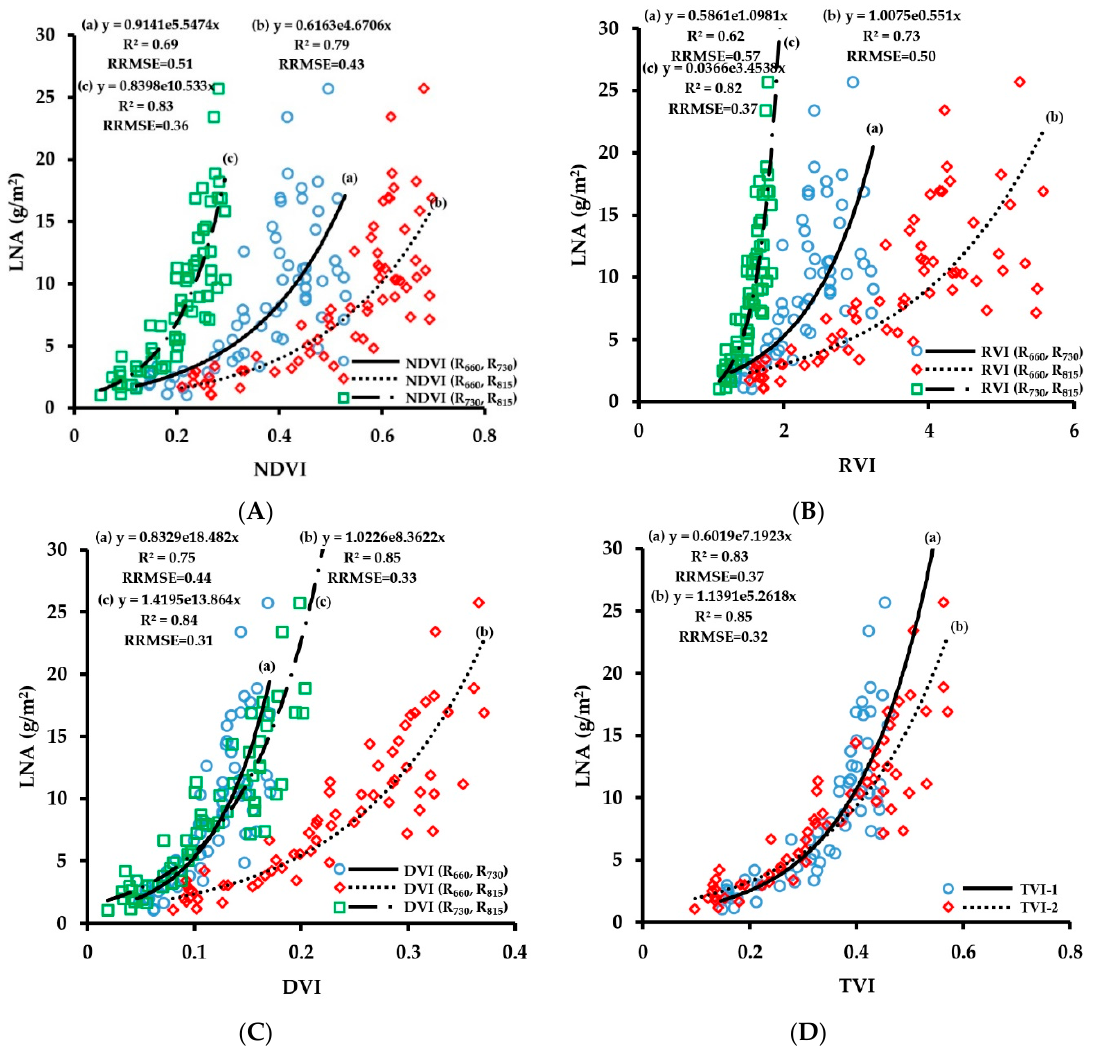
Figure 12. Fitting curve of NDVI ( A ), RVI ( B ), DVI ( C ) and TVI ( D ) to LNA of wheat.